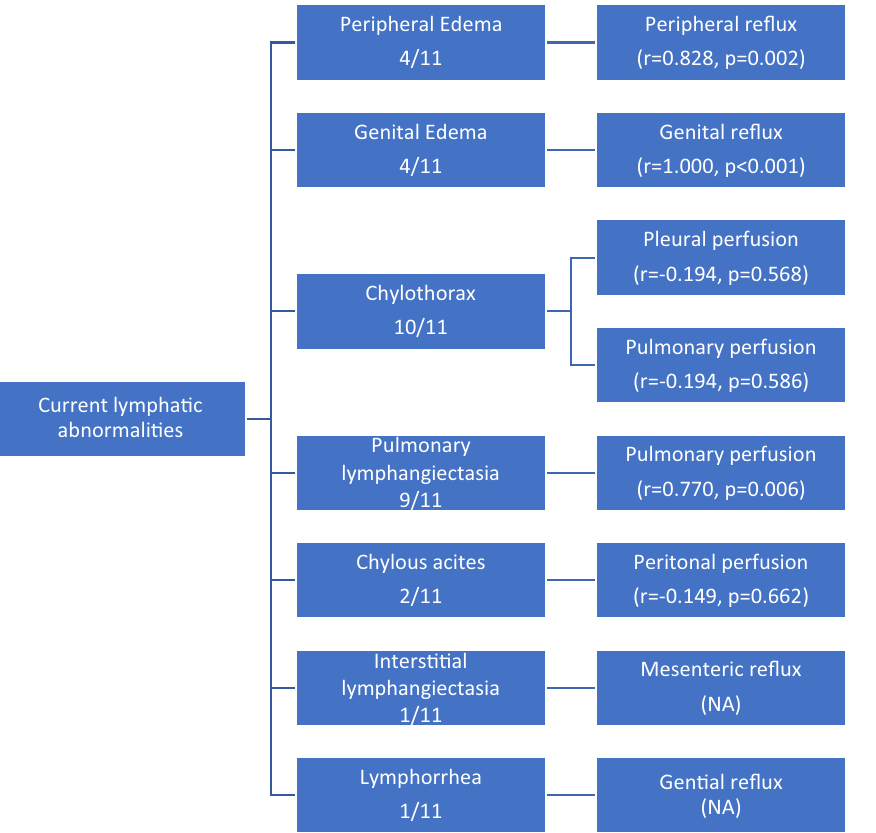
Figure 8. Correlation of current symptoms and major imaging findings (statistical results of Pearson’s